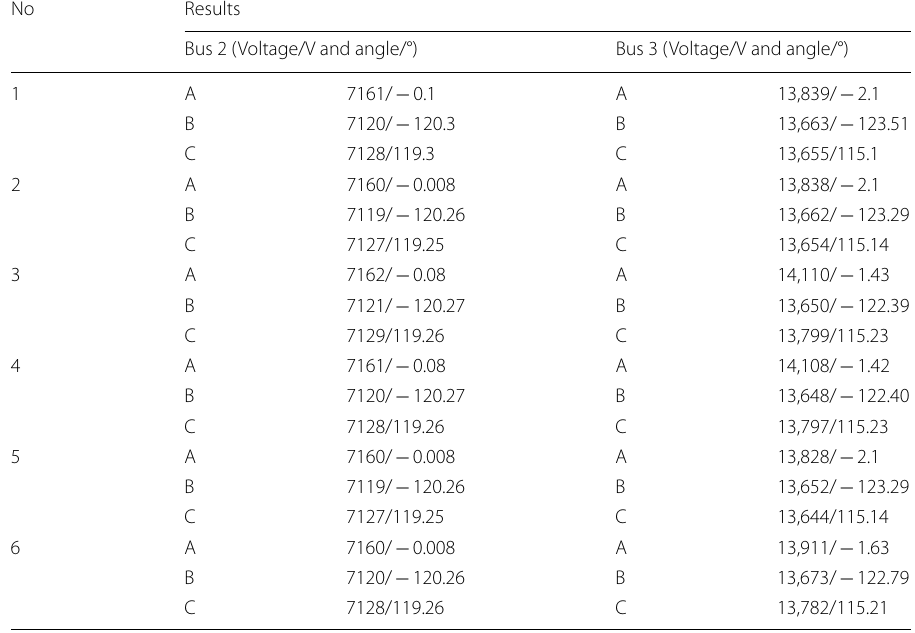
Table 4 Results of power flow calculations for the transformer in YN, yn 0 connection No Results Bus 2 (Voltage/V and angle/°)